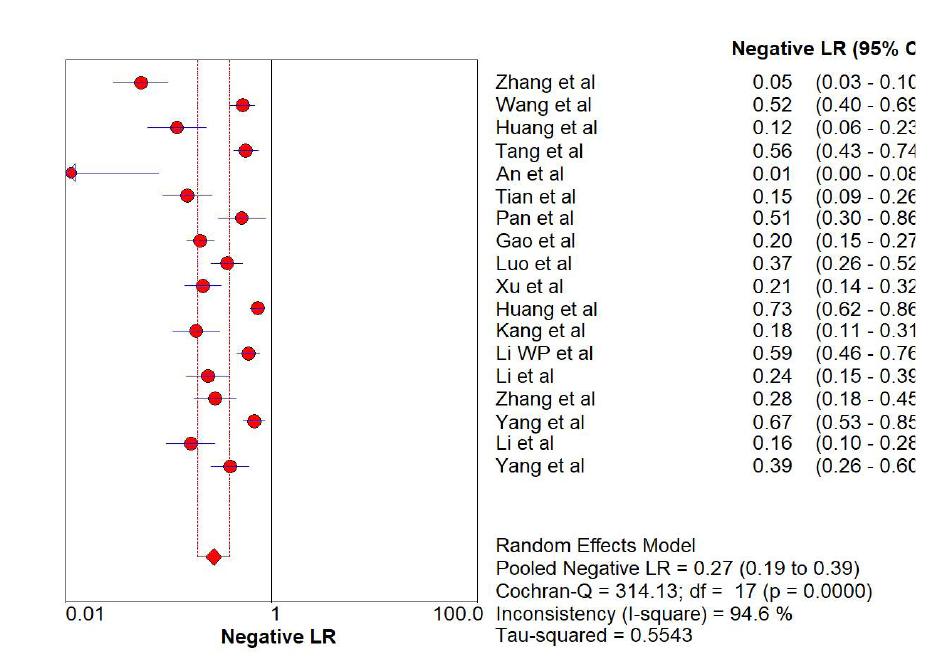
Figure 4: The forest plot of diagnostic -LR for serum Hcy in diagnosis of